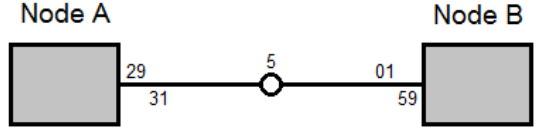
Figure 8. Five intermediate stops between nodes A and B, the number of grouped stops is indicated with a numeric descriptor next to an empty circle.